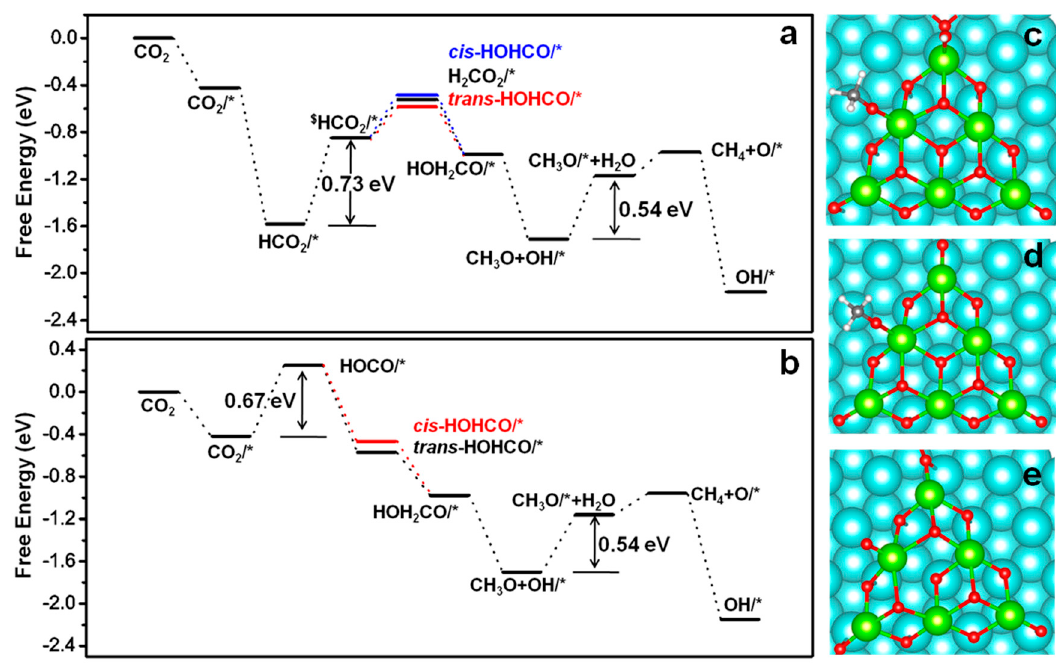
Figure 5. Free energy diagrams for the formation of methane. ( a ) HCO 2 * path. ( b ) HOCO* path. ( c – e ) most stable structures for important stationary point involved in the formation of methane. ( c ) (CH 3 O+OH)*, ( d ) CH 3 *, ( e ) O*.